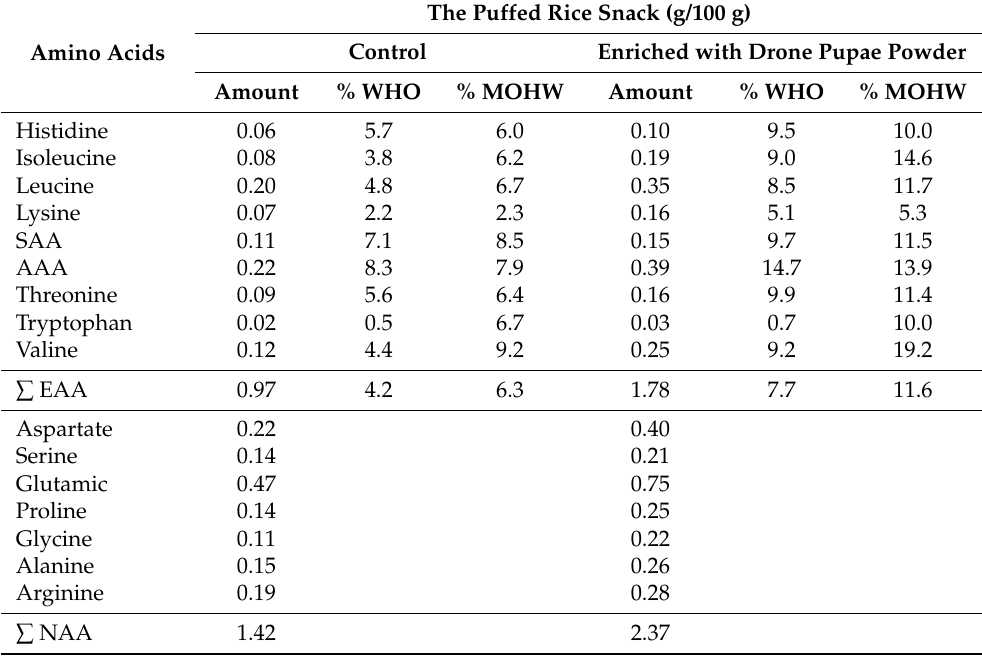
Table 14. The total amino-acid composition of the control and drone-pupae-powder enriched puffed-rice snack. The Puffed Rice Snack (g/100 g) Control Enriched with Drone Pupae Powder Amino Acids Amount % WHO % MOHW Amount % WHO % MOHW